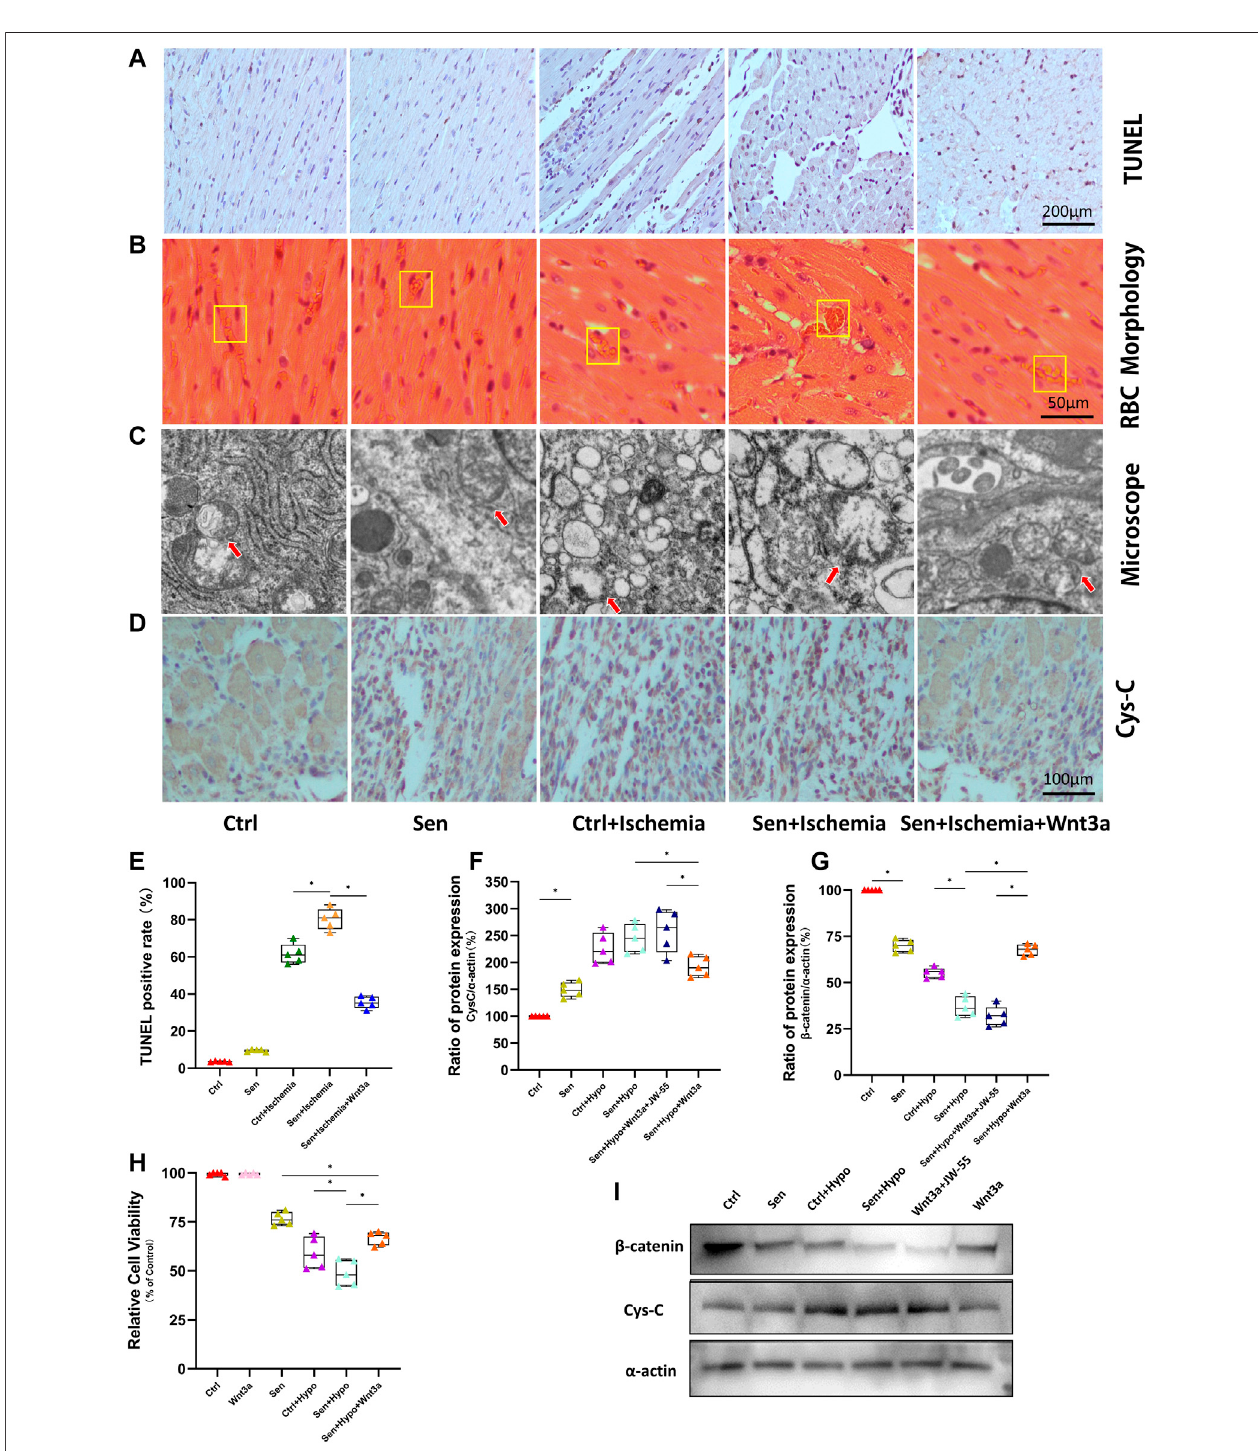
FIGURE2| EffectsofWnt-3aonmyocardialapoptosis,microcirculation,mitochondrialmorphologyandexpressionofCys-C and β -catenin. Myocardialapoptosis in the infarcted area of different groups was evaluated by immunohistochemistry and TUNEL staining with images, the brown stained nuclei in the Sen + Ischemia + Wnt3a group showed a signi fi cant decrease compared with the Sen + Ischemia group (A) . The arrangements of myocardial tissues and RBC in the microcirculation of AMI lesions in different groups were shown with HE staining, the Sen + Ischemia +Wnt3a group showed signi fi cantly improved myocardial morphology compared with the Sen + Ischemia group (B) . Mitochondrial morphology in different groups was viewed by electron microscopy, the mitochondria in the Sen + Ischemia + Wnt3a group recovered toanovalshape (C) . Representative immunohistochemistrystainingimagesoftheexpression ofCys-C ininfarctedregions indifferentgroups, theSen